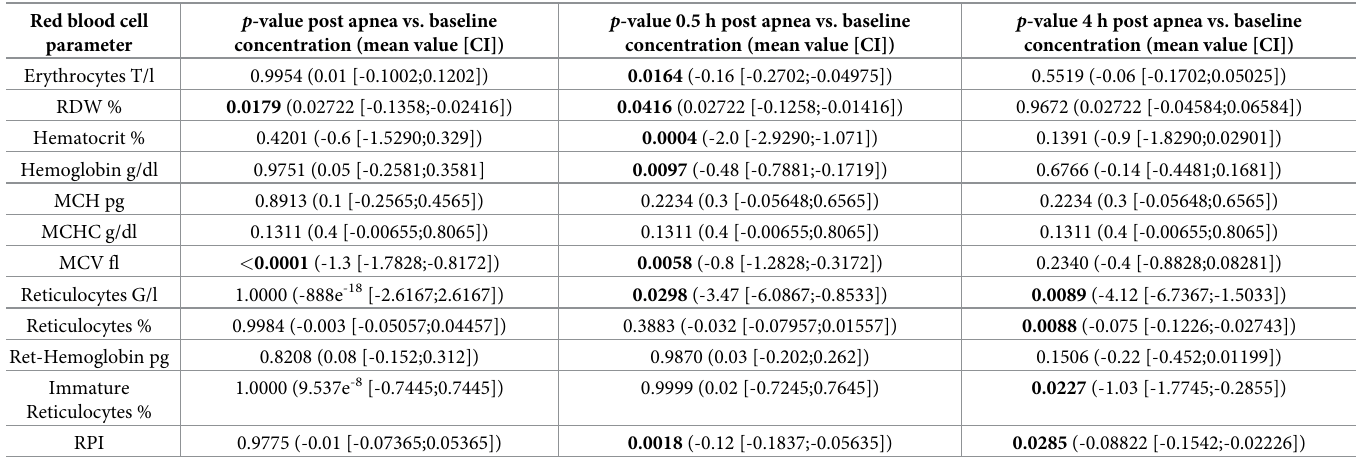
p -values, mean values and confidence intervals (CI) for change for the differences between the three time intervals post apnea, 0.5 h and 4 h post apnea versus baseline concentrations for erythrocytes, RDW, hematocrit, hemoglobin, MCH, MCHC, MCV, reticulocytes, ret-hemoglobin, immature reticulocytes and RPI. Significant p - values are marked in